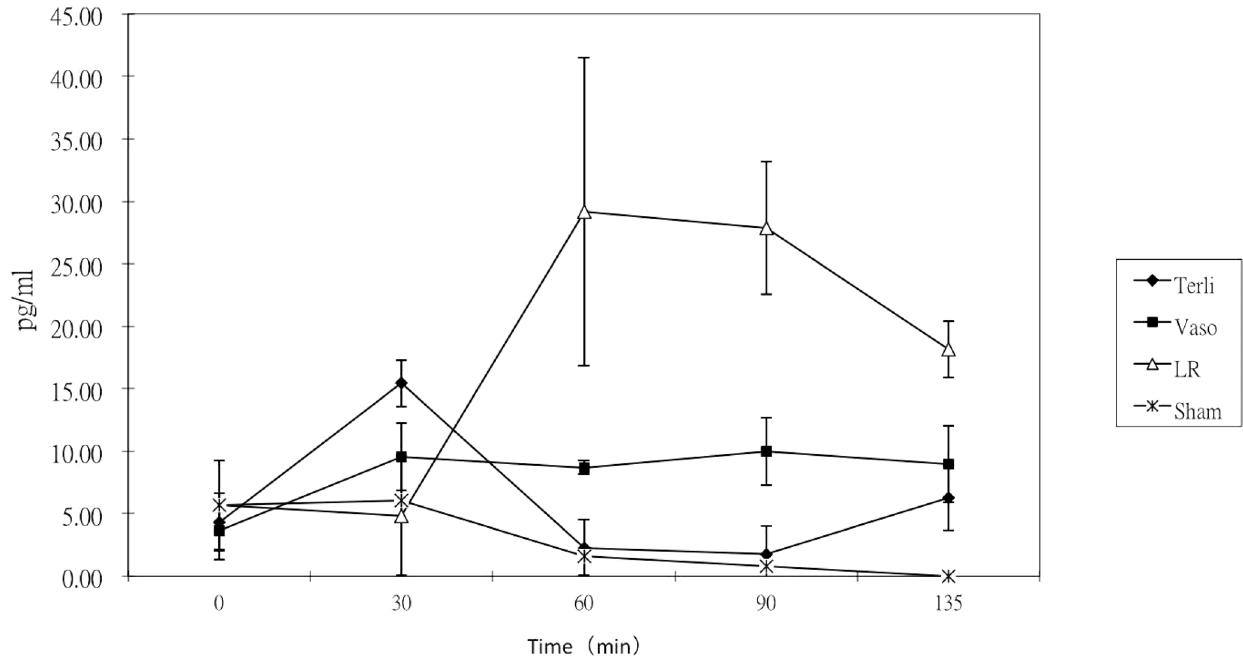
Figure 3. Comparison of serum IL-6 levels between different resuscitation strategies groups from 0 to 135 min. Data are shown as mean values and standard deviations. There were no significant differences in baseline levels. Serum levels of IL-6 in the LR group were significantly higher than those in the Vaso (P , 0.001), and Terli (P , 0.001) groups from 60 to 135 mins. Serum levels of IL-6 in the Vaso group were significantly higher than those in the Terli (P , 0.001) group from 60 to 90 mins. There were no significant differences of serum IL-6 levels between the Vaso and